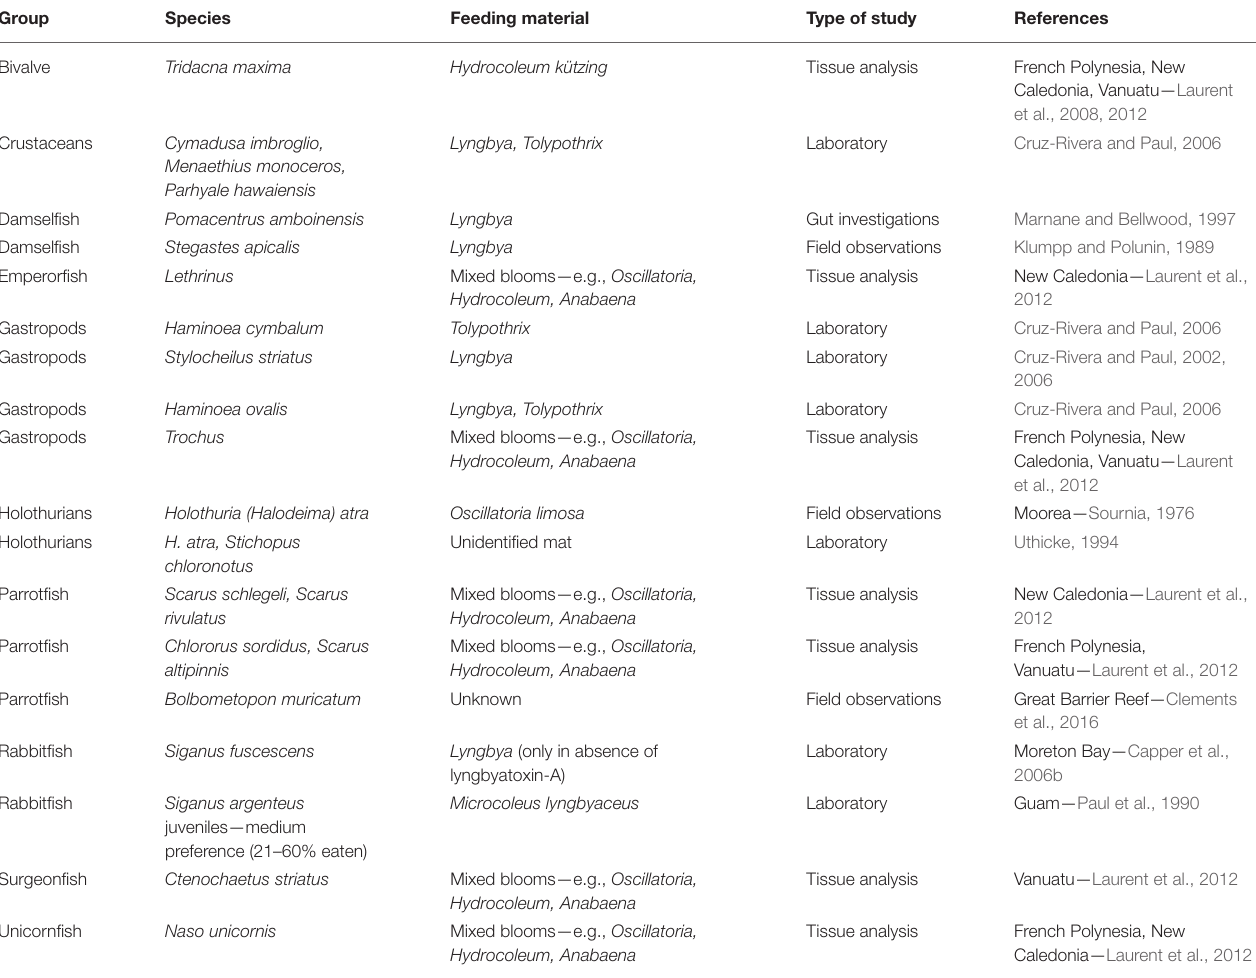
TABLE 2 | Documented reports of cyanobacterial mat consumption by coral reef-associated